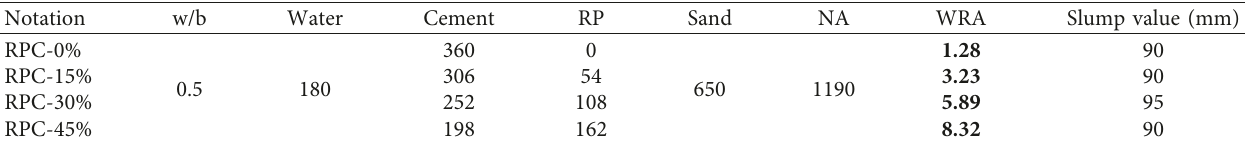
Table 3: Mix proportions of RPC (kg/m 3